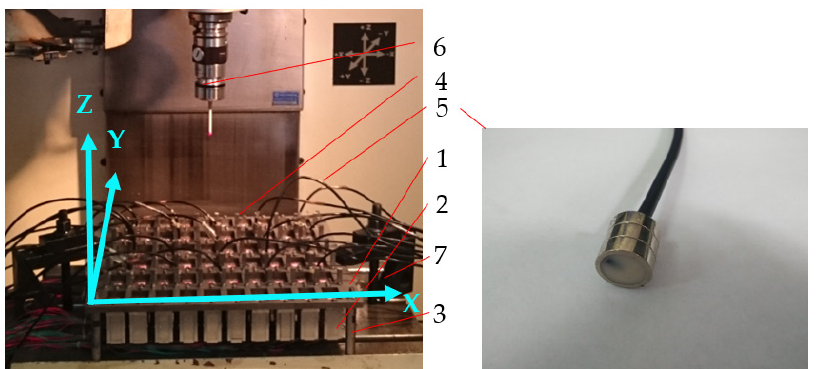
Figure 2. Photo of experimental devices. 1. panel; 2. heater ( 10 × 6 ); 3. column ( 2 × 2 ); 4. cuboid measuring standard part ( 11 × 5 ); 5. temperature sensor (number: 20); 6. probe of a coordinate- measuring machine (CMM); 7. fixed devices (number: 2).